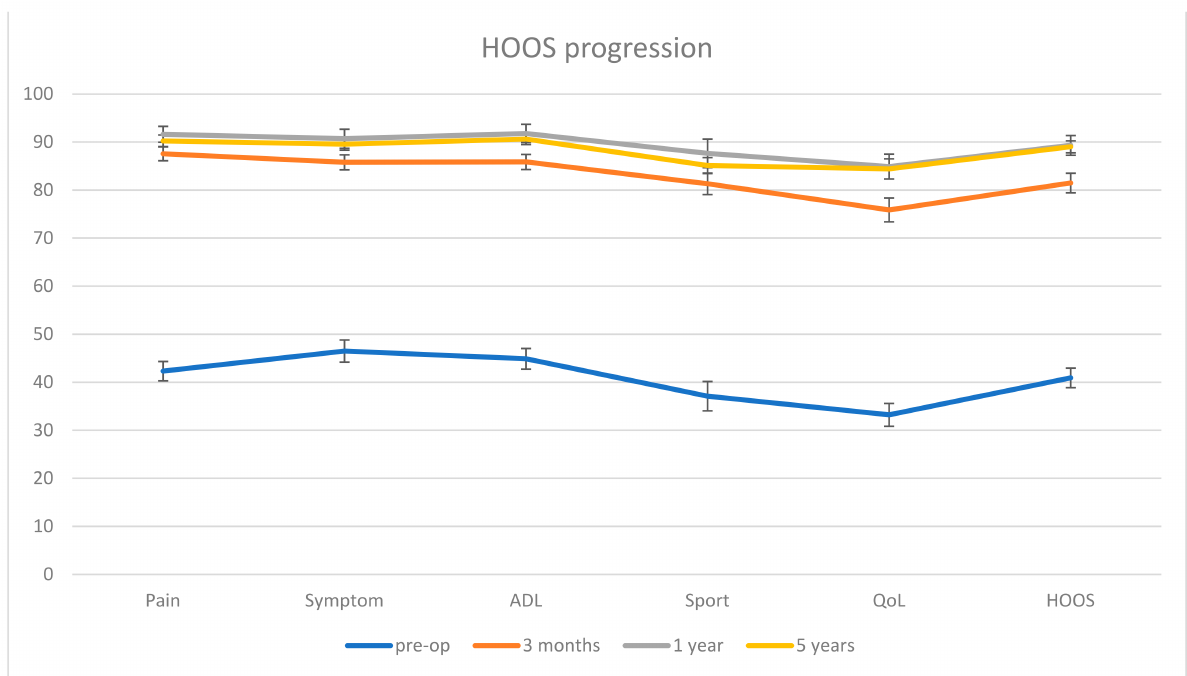
Figure 4. Progression of the HOOS score. The error bars represent the standard error at 95%.